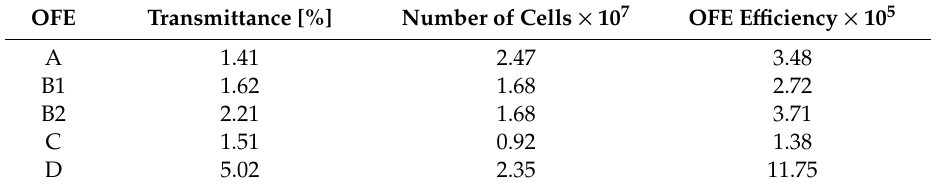
Table 2. Calculated transmittance, cell number and e ffi ciency of the five OFEs used in this study. OFE Transmittance [%] Number of Cells × 10 7 OFE E ffi ciency × 10 5 A 1.41 2.47 3.48 1.62 1.68 2.72